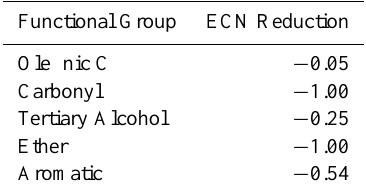
Table 3. ECN corrections applied for analysis in this